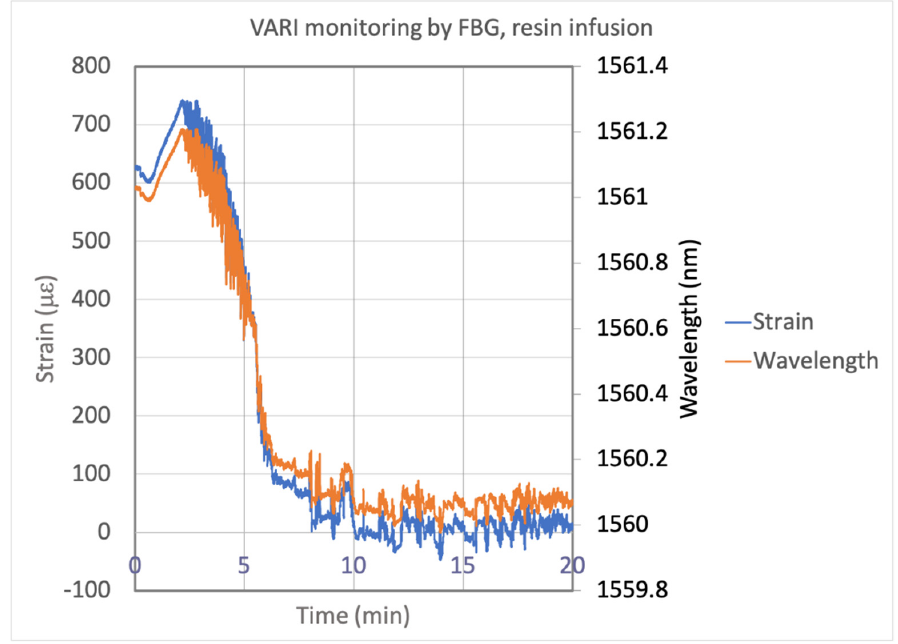
Figure 8. VARI monitoring by FBG, resin infusion, measuring the evolution of the flow front. When curing starts, there is a more notable variation in the microstrains sensed by the FBG, as shown in Figure 9. Curing strain initial value is − 50 µε and reaches an average value of 25 µε after 1 h. This is caused by the exothermic reaction, which contributes to the rising of inner